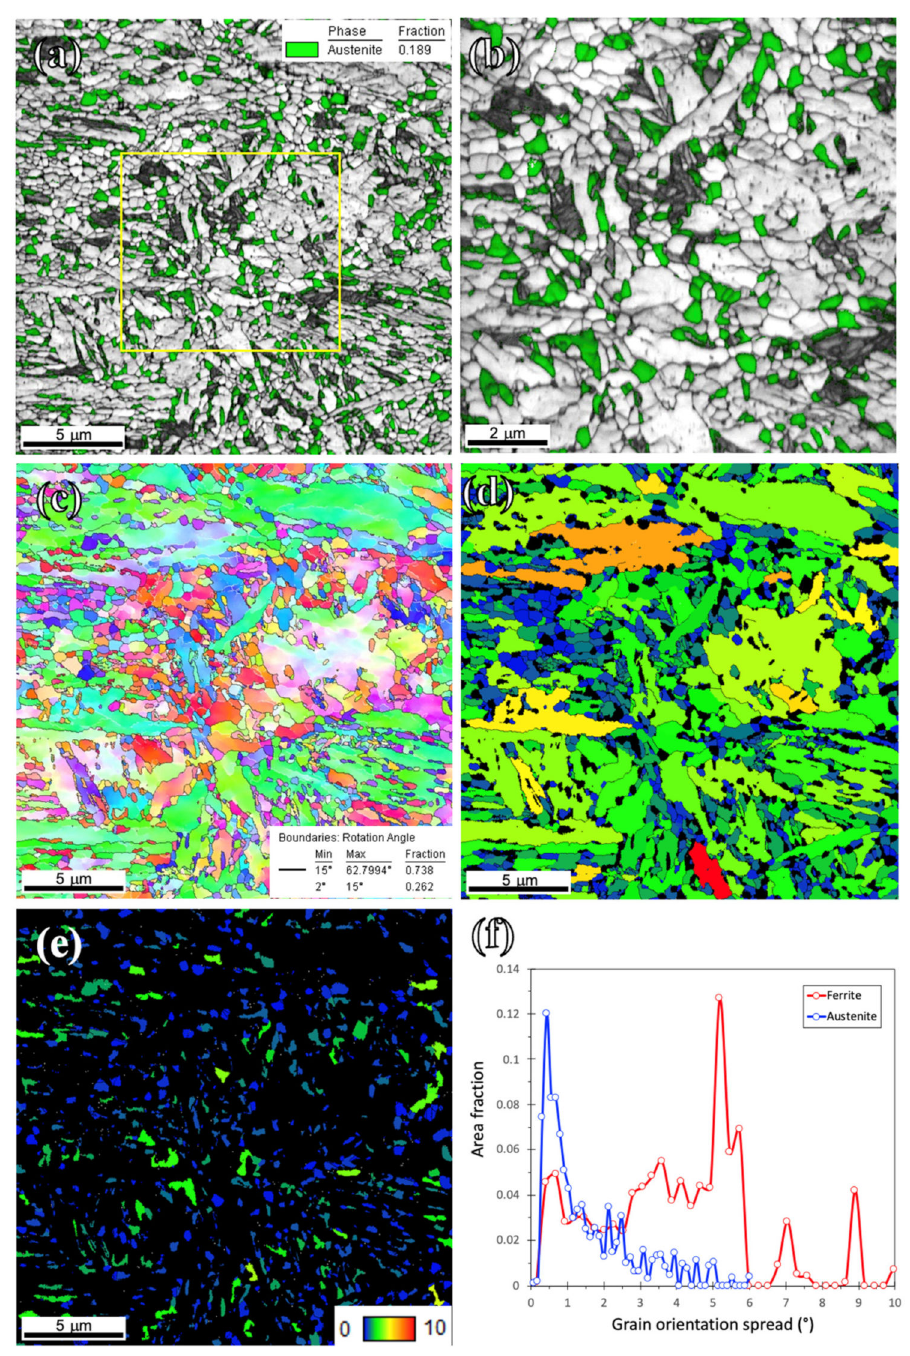
Figure 7. EBSD maps of the Def-A650 sample. ( a ) IQ map overlayed by phase map, ( b ) higher magnification of the marked area in ( a ), ( c ) IPF and ( d , e ) grain orientation spread (GOS) maps; and ( f ) GOS distribution for ferrite and